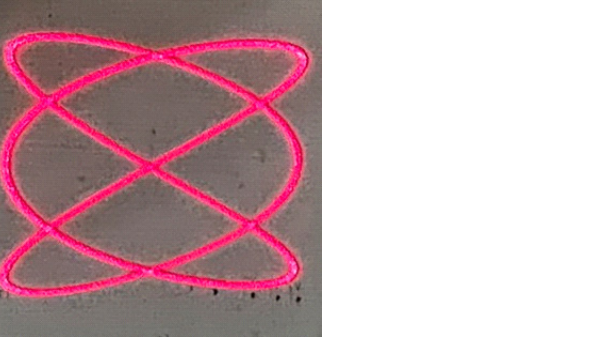
Figure 10. Lissajous scanning with the frequencies of the x and y scans being 70 and 58 Hz, respec-